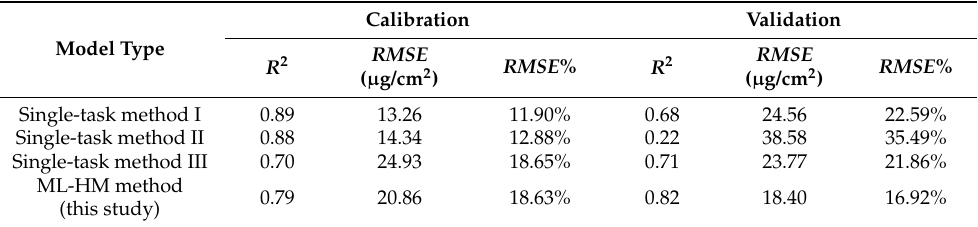
Table 5. LNC prediction results using different structures to design the hybrid